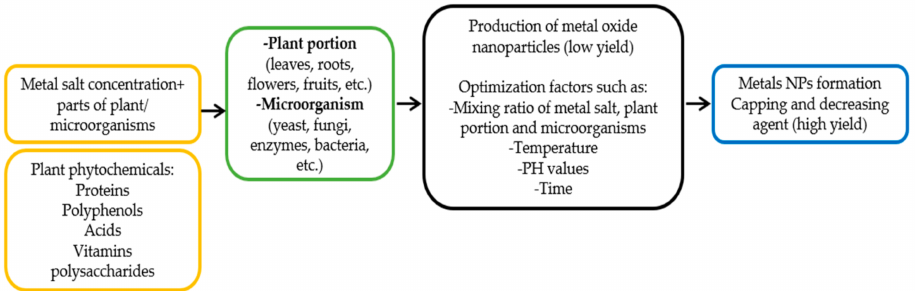
Figure 6. Green synthesis of metal oxide using various plants portions and microorganisms. Elabora- tion from Ref. [86].